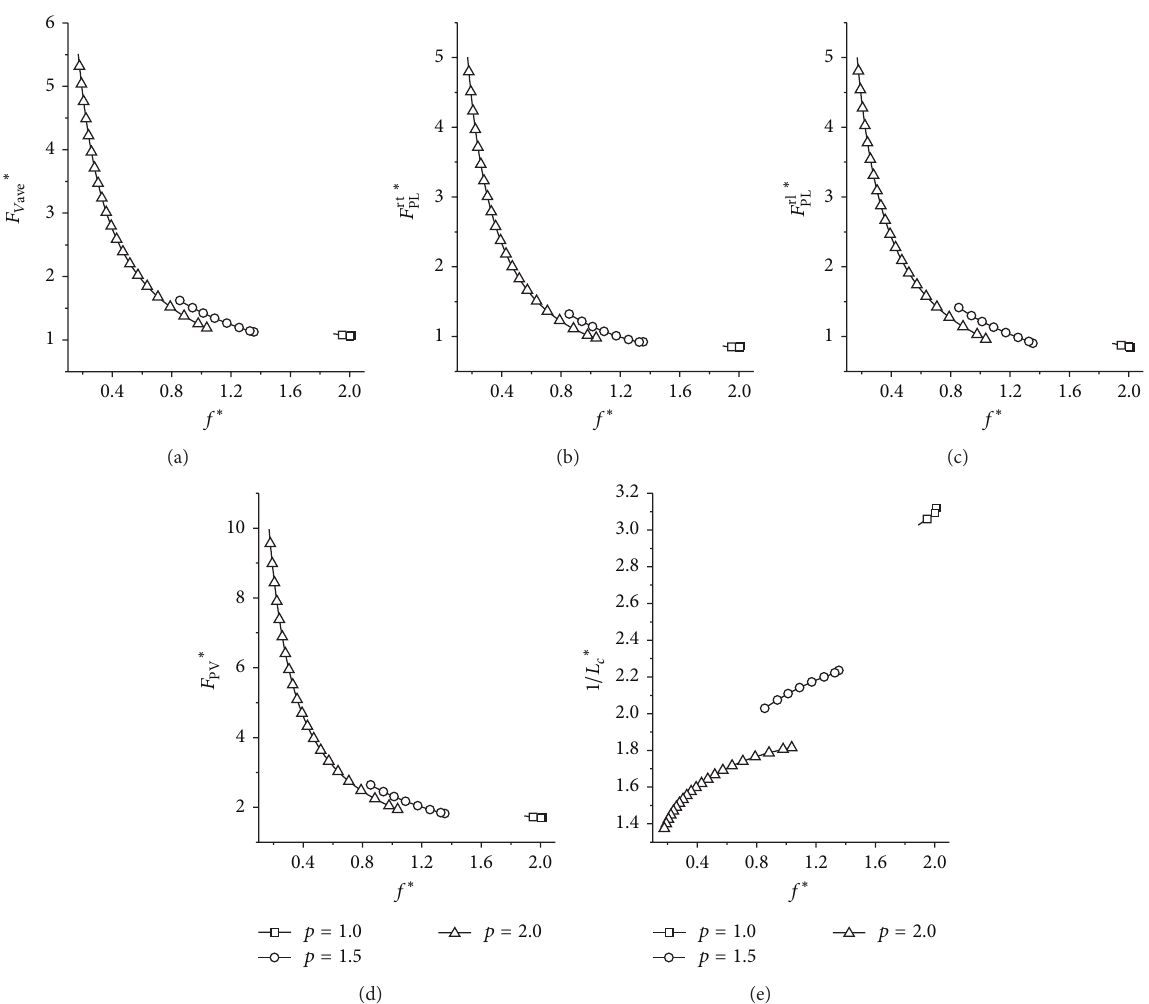
Figure 10: Influence of different body proportions on the rotary galloping model. (a) The average vertical force; (b) and (c) are the peak leg force for the rear trailing leg and the leading leg, respectively. (d) The peak ground reaction force; (e) the result of the indicator of the metabolic cost of transport. Initial conditions: 𝑦 ∗ 𝑠 = 1 , 𝜇 = 0.05 , V ∗ = 1.4 , and 𝑘 𝑎 = 1.0